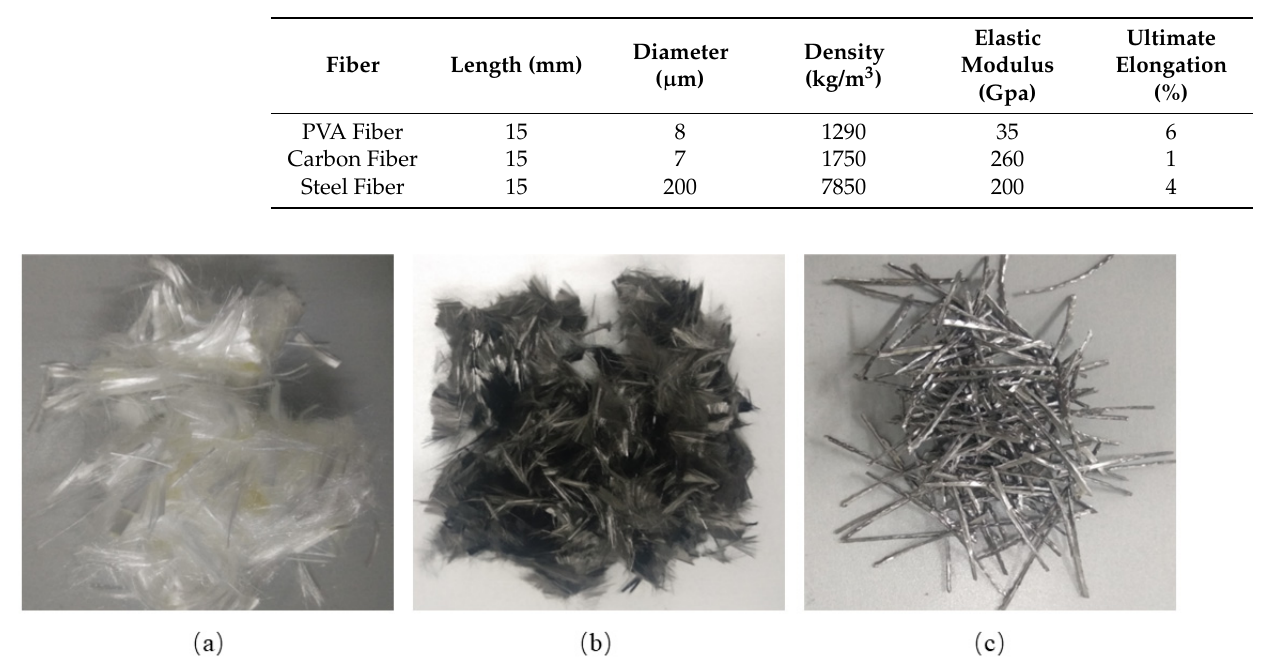
Figure 1. Fiber appearance. ( a ) PVA Fiber; ( b ) Carbon Fiber; ( c ) Steel